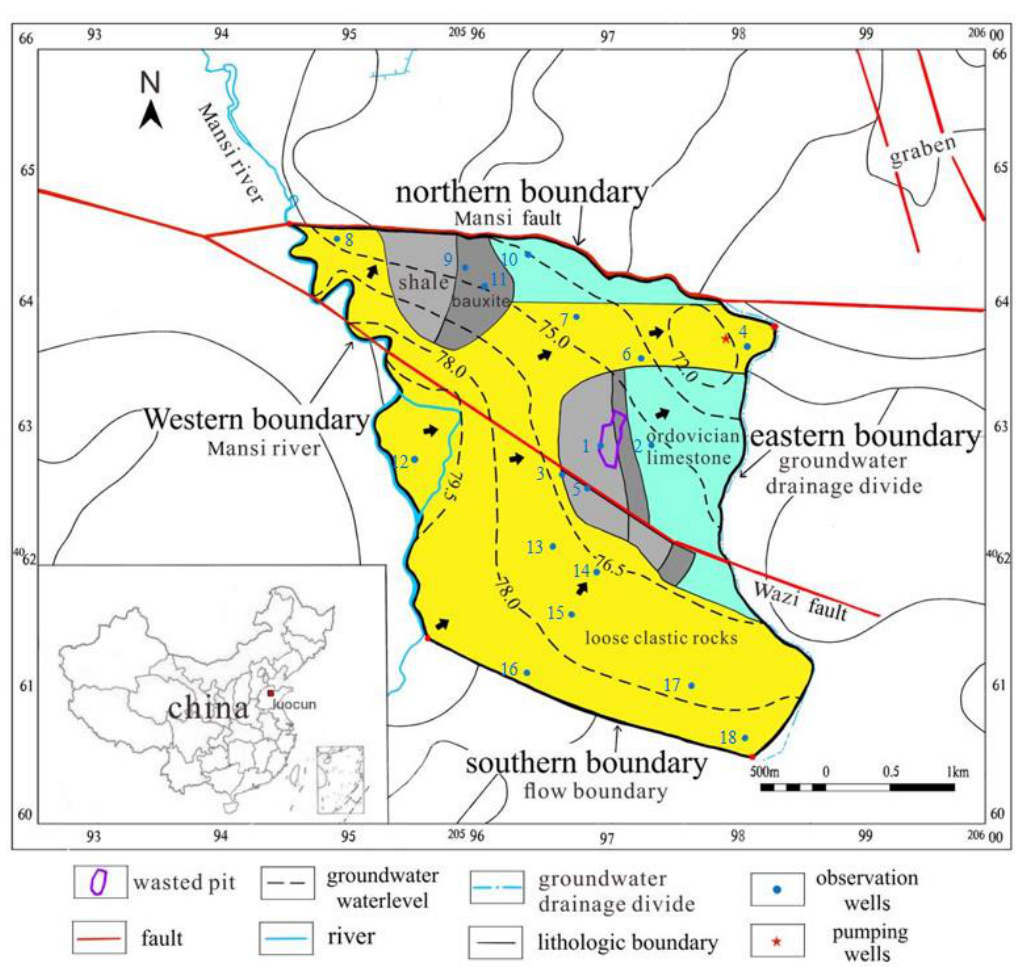
Figure 2. Hydrogeological map of the study